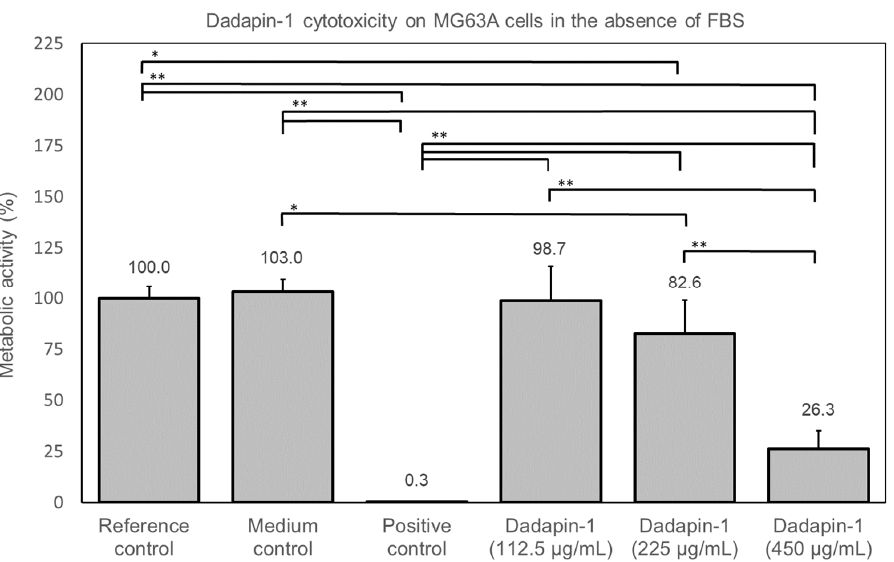
Figure 3. This bar graph reports the metabolic activity observed in the MG63 after the treatment with the three highest investigated concentrations of Dadapin-1 in the absence of FBS. The RLU values of the luminescence assay were normalized with respect to the reference control, which was equated to 100%. For the different controls, the bars report the mean ± S.D. of 8 measurements and for Dadapin-1 of 6 measurements from two independent experiments. The data were statistically analyzed by ANOVA followed by Bonferroni/Dunn test. Comparisons are not significant unless p < 0.0033. Legend: *, p < 0.0033; **, p < 0.0001.